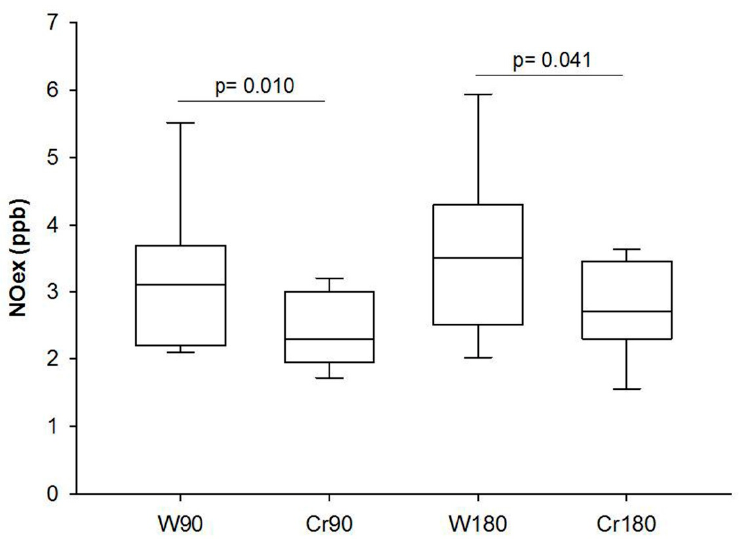
Figure 2. Exhaled nitric oxide (parts per billion). W90, control / water + 90 min of ischemia; Cr90, creatine + 90 min of ischemia; W180, control / water + 180 min of ischemia; Cr180, creatine + 180 min of ischemia. Data are expressed as median and interquartile range. W90 vs Cr90 and W180 vs Cr180 ( n = 8 animals/group).